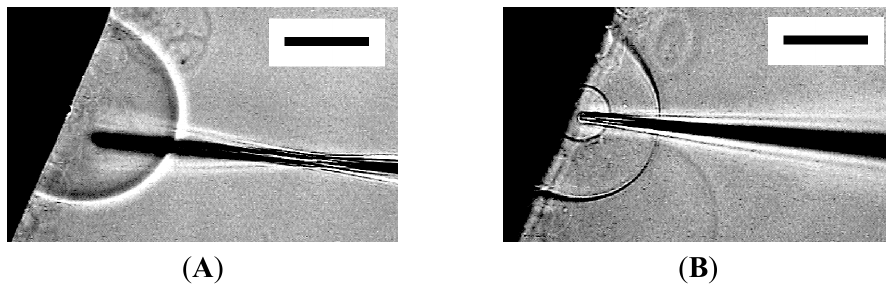
Figure 7. Microinjection and microvesiculation to a single semi-sphere. After microinjection with a microneedle ( A ), the needle was pulled out. Then the same needle was reinserted, and this time, microvesiculation occurred ( B ). Bar = 50 μ